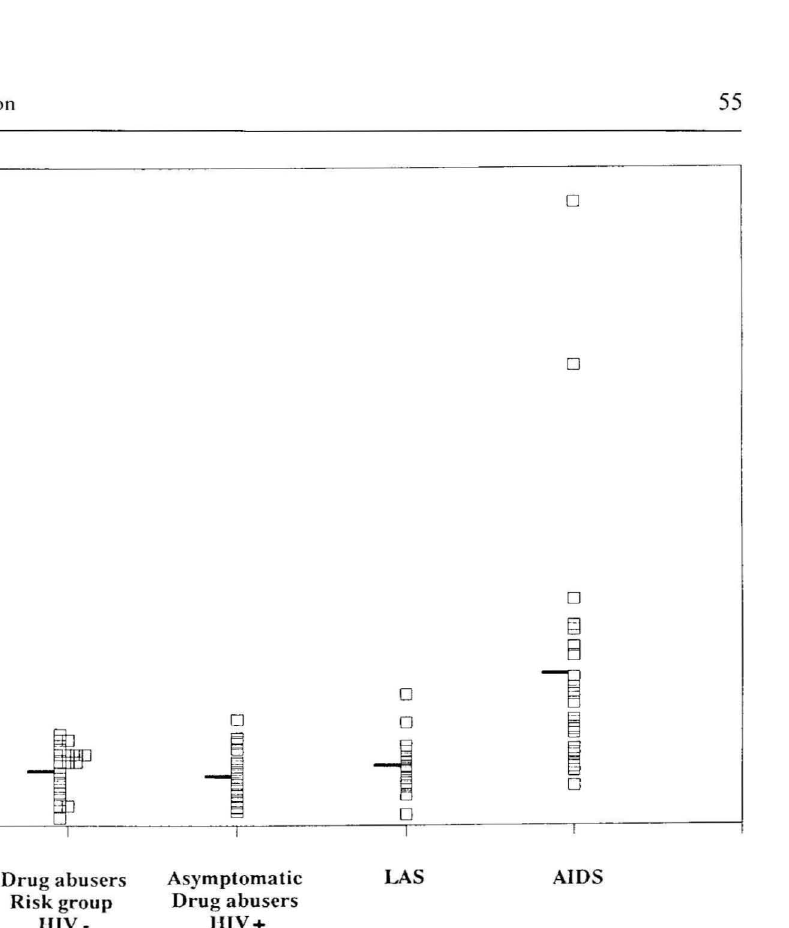
Figure 3. Soluble rIL-2 levels in sera of asymptomatic i. v. drug abusers and patients with lymphadenopathy or A IDS.